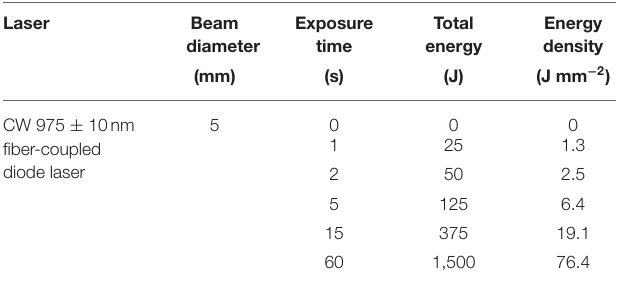
TABLE 2 | Summary of laser exposure and energy parameters for the CW 25W, 975nm fiber-coupled diode laser. Laser